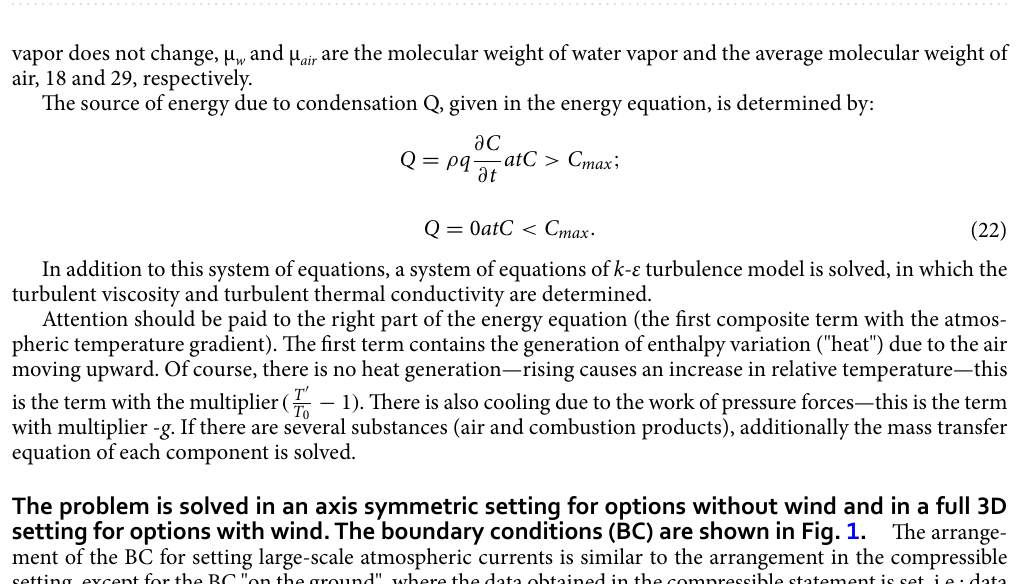
Figure 1. Jet shape and boundary